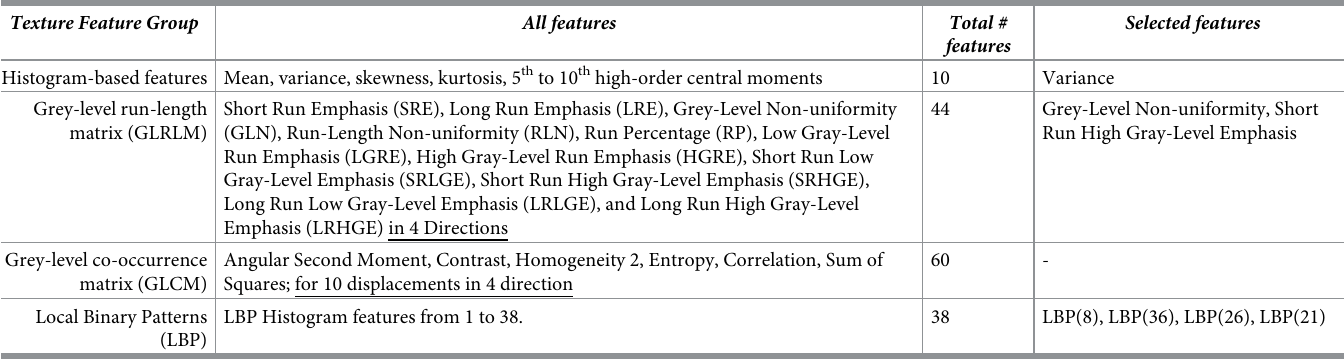
Table 1. Summary of the extracted and selected texture features. Texture Feature